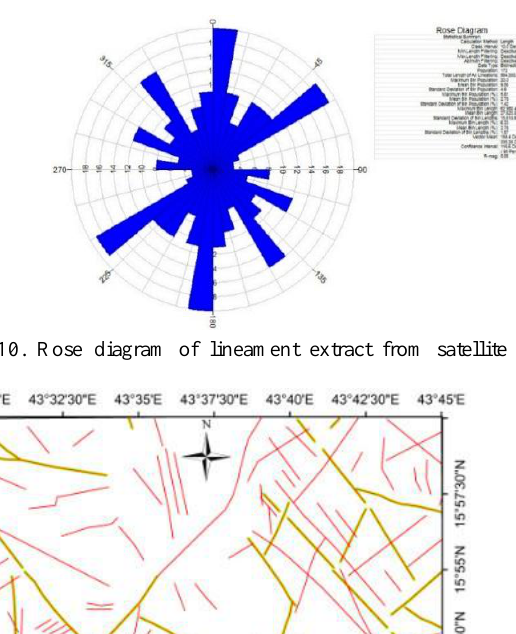
Figure 9. Final map of Lineament extraction from satellite image